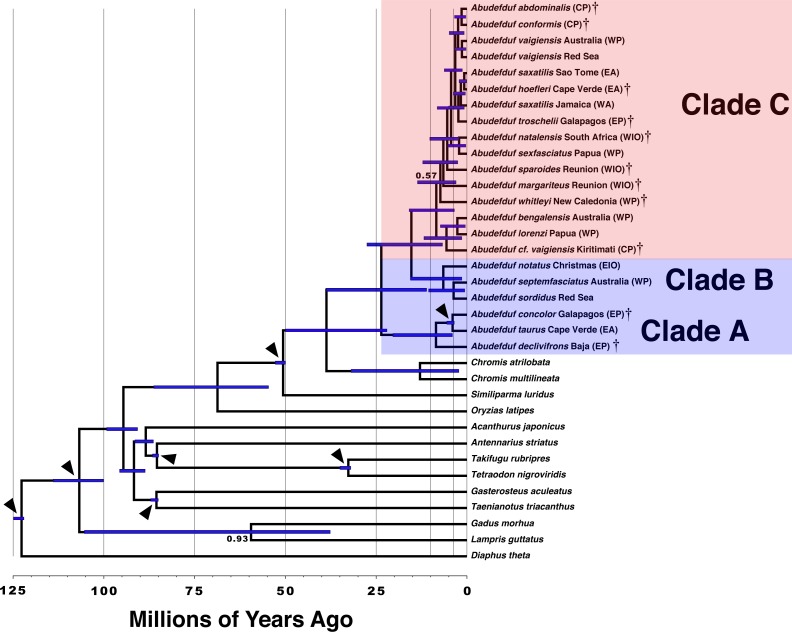
Time-calibrated phylogenetic tree of Abudefduf.A time-calibrated phylogenetic tree of Abudefduf generated from 137 ultraconserved element (UCE) loci modeled under a single partition with the General Time Reversible (GTR) model with gamma-distributed rate variation (Γ). Fossil-calibrated nodes are indicated by black triangles and are described in Table S2. Posterior support at nodes is 1.00 unless otherwise indicated. Blue bars indicate 95% highest posterior density. The major trophic guilds are indicated by shading of red for planktivores and blue for benthivores. Regional endemics are indicated by a dagger (†). Invidual samples included in this analysis are indicated in Table S1. Vertical lines indicate 25 million year time divisions with 10 million years and 3 million years also indicated. Appended to each leaf in the tree is the approximate geographic location of the sequenced individual using these abbreviations: EA, East Atlantic; WA, West Atlantic; EP, East Pacific; CP, Central Pacific; WP, West Pacific; EIO, East Indian Ocean, and WIO, West Indian Ocean.